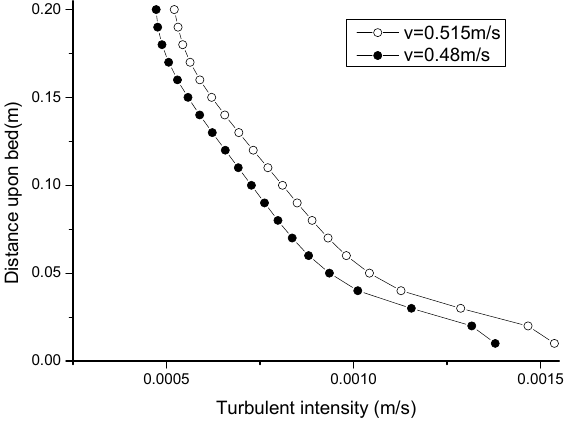
Figure 9. Comparison of the turbulent intensity distribution along the water depth with two cases of cross-sectional average velocity 0.48 and 0.515m/s.